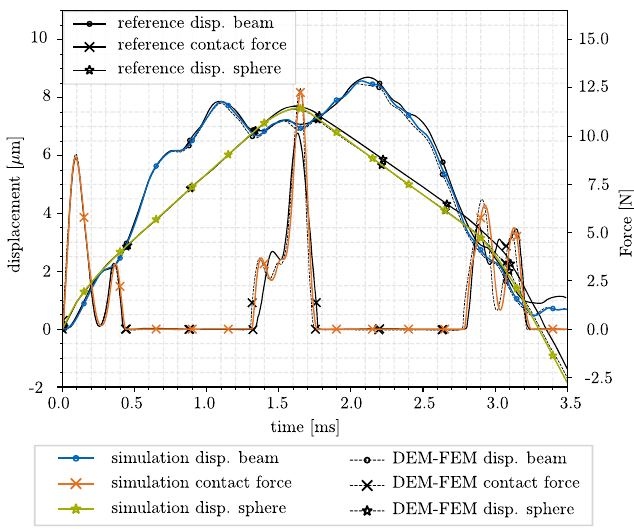
Fig. 8 Single spanned beam with a total length of 30 . 70cm hit laterally at its center by a sphere with radius R = 2cm. Numerical results compared to reference solution [70] and numerical results of a DEM-FEM coupling scheme conducted by